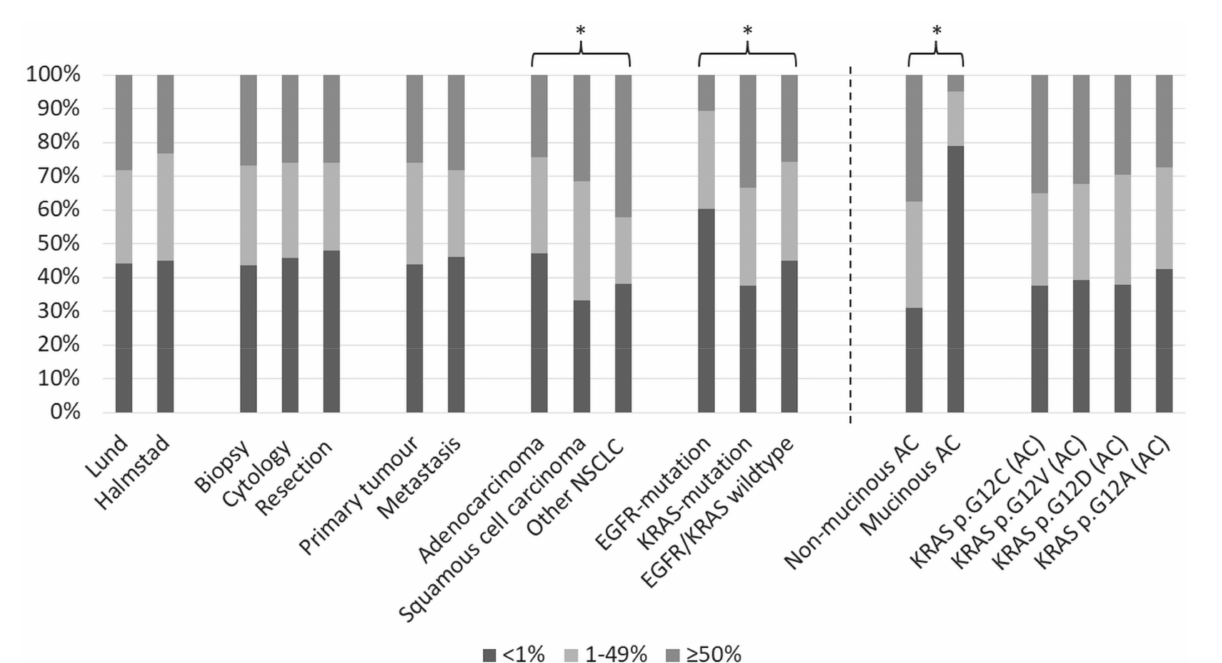
Figure 2. PD-L1 expression levels in all 1381 non-small cell lung cancer (NSCLC) specimens with complete data (left of dashed line) and the 403 KRAS-mutated adenocarcinomas (AC) (* marks statistical significance, all p < 0.001; see Tables 2 and 3 and text for full data and